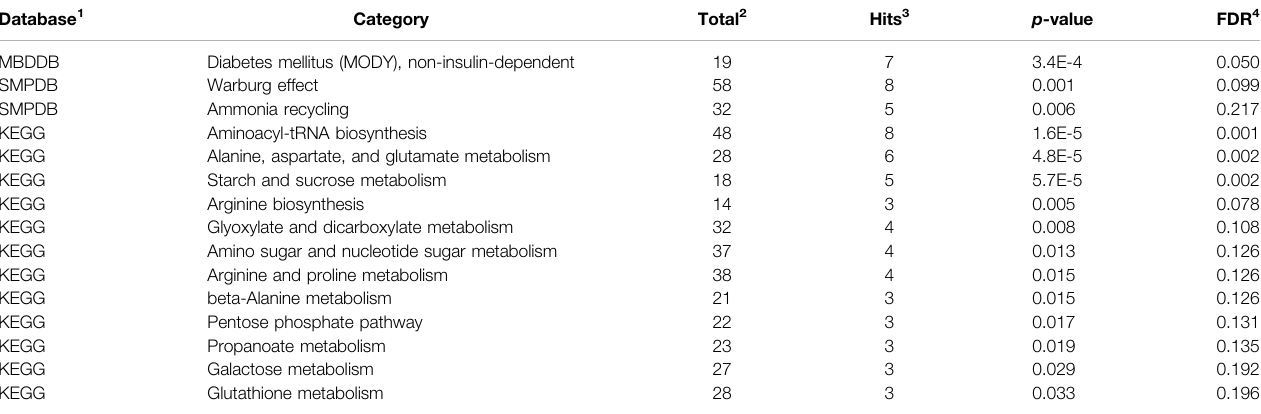
TABLE 3 | Metabolites presenting at least one effect, maternal immune activation alone or interacting with weaning or sex, at p -value < 0.05.